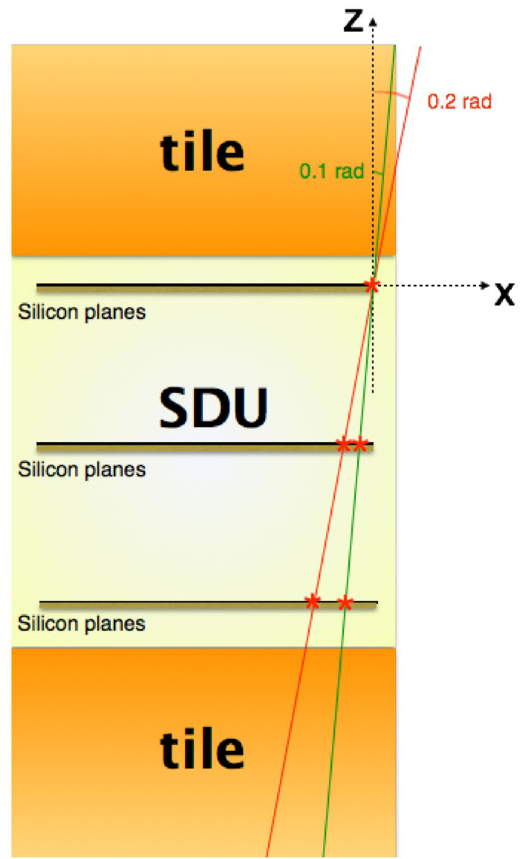
Figure 7. Schematic of the SDU with the two tiles on the top and on the bottom. The two drawn particle trajectories feature 0.1 rad (green) and 0.2 rad (red) inclination and are the most external ions with that inclination that can trigger the SDU (passing in all six silicon planes). The 0.2 rad most external trajectory passes only partly through the tile, while the 0.1 rad trajectory traverses all the